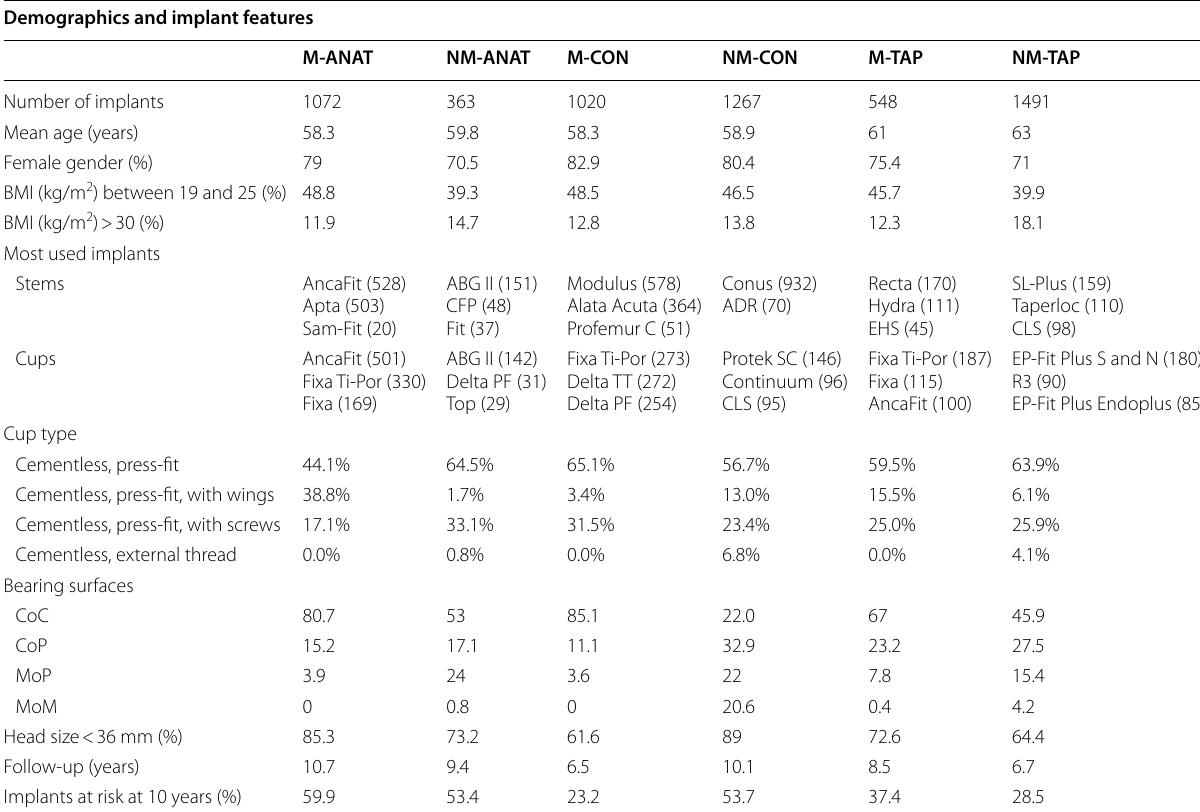
Table 1 Demographics were homogeneous in the six cohorts, whereas implant-related features were not similar Demographics and implant